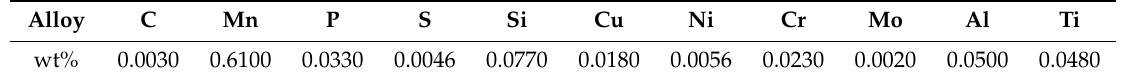
Figure 3. Schematic drawing (mm) of the test specimens used in the experiments, dimensions based on AWS B4.0 standard.